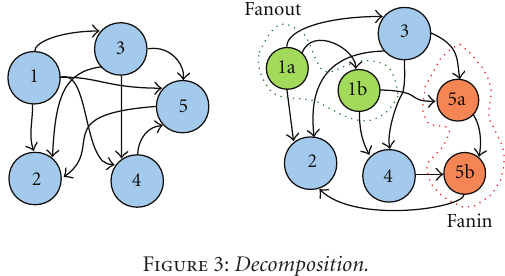
Figure 3: Decomposition.